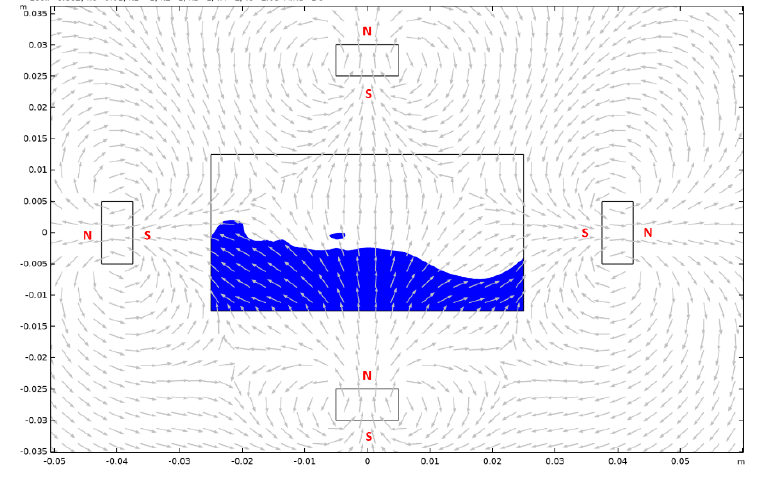
Figure A22. Case 8.